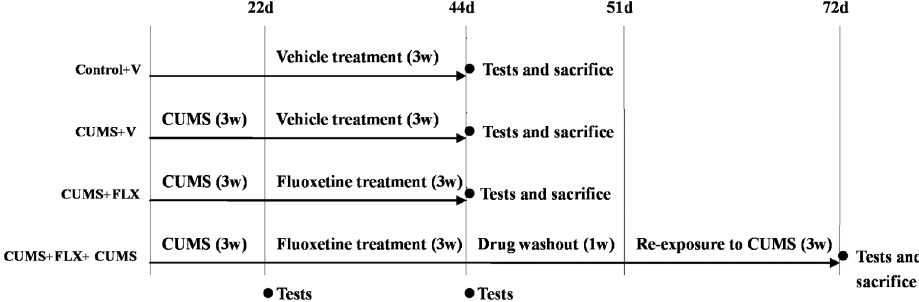
Figure 1. Details of the experimental procedure. Control++V, CUMS++V, and CUMS++FLX rats were tested (via the sucrose preference test) at 22 days and 44 days and sacrificed within 12 h of the last test. Rats in the CUMS++FLX++CUMS group were tested (via the sucrose preference test) at 22, 44, and 72 days, and sacrificed within 12 h of the last test. V: vehicle; CUMS: chronic unpredictable mild stress; FLX: fluoxetine; d: days; w: